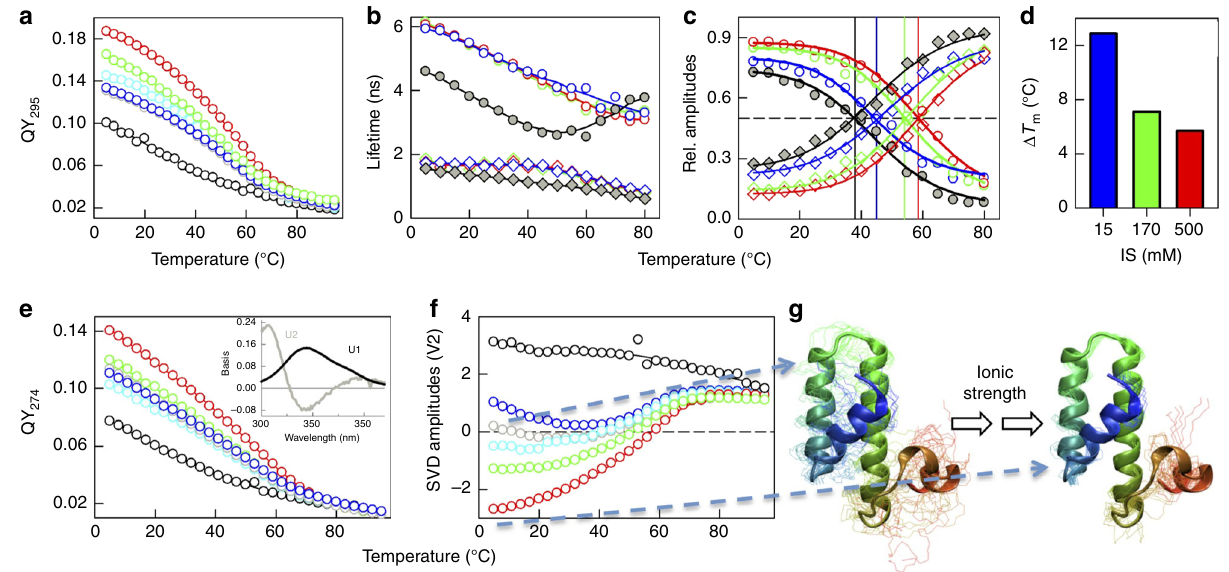
Fig. 3 Large-scale structural re-arrangements within the native ensemble. a QY of W67 as a function of temperature at 14.5 mM (blue), 43 mM (gray), 90 mM (cyan), 170 mM (green), and 500 mM IS (red). The QY at 6 M urea is shown as a reference (black). Note the large changes in QY even at the lowest temperatures where unfolded population is negligible. b Longer and shorter fl uorescence lifetimes of W67 as circles and diamonds, respectively. The color code is the same as in panel a . The fi lled gray symbols represent the life-times of tryptophan in the reference peptide C-pep. c The relative amplitudes following the same color code as in b . The vertical lines indicate the in fl ection points. d Difference in melting temperatures between far-UV CD and W67 life-time amplitudes calculated as T m (CD) – T m (Life-time). e QY of the Cnu upon excitation at 274 nm exhibiting similar characteristics as that of QY 295 and following the same color code as in panel a . (Inset) Spectral deconvolution of temperature-wavelength data shows two components, the fi rst of which accounts for the average spectrum (U1) and the second represents an anti-correlation between tryptophan and tyrosine fl uorescence emission bands (U2). f The amplitude of U2 following the color code as in panel a . g A pictorial representation of the conformational events monitored by the data shown in panel f with a large structural heterogeneity at low IS that decreases continuously with increase in the salt concentration. Source data are provided as